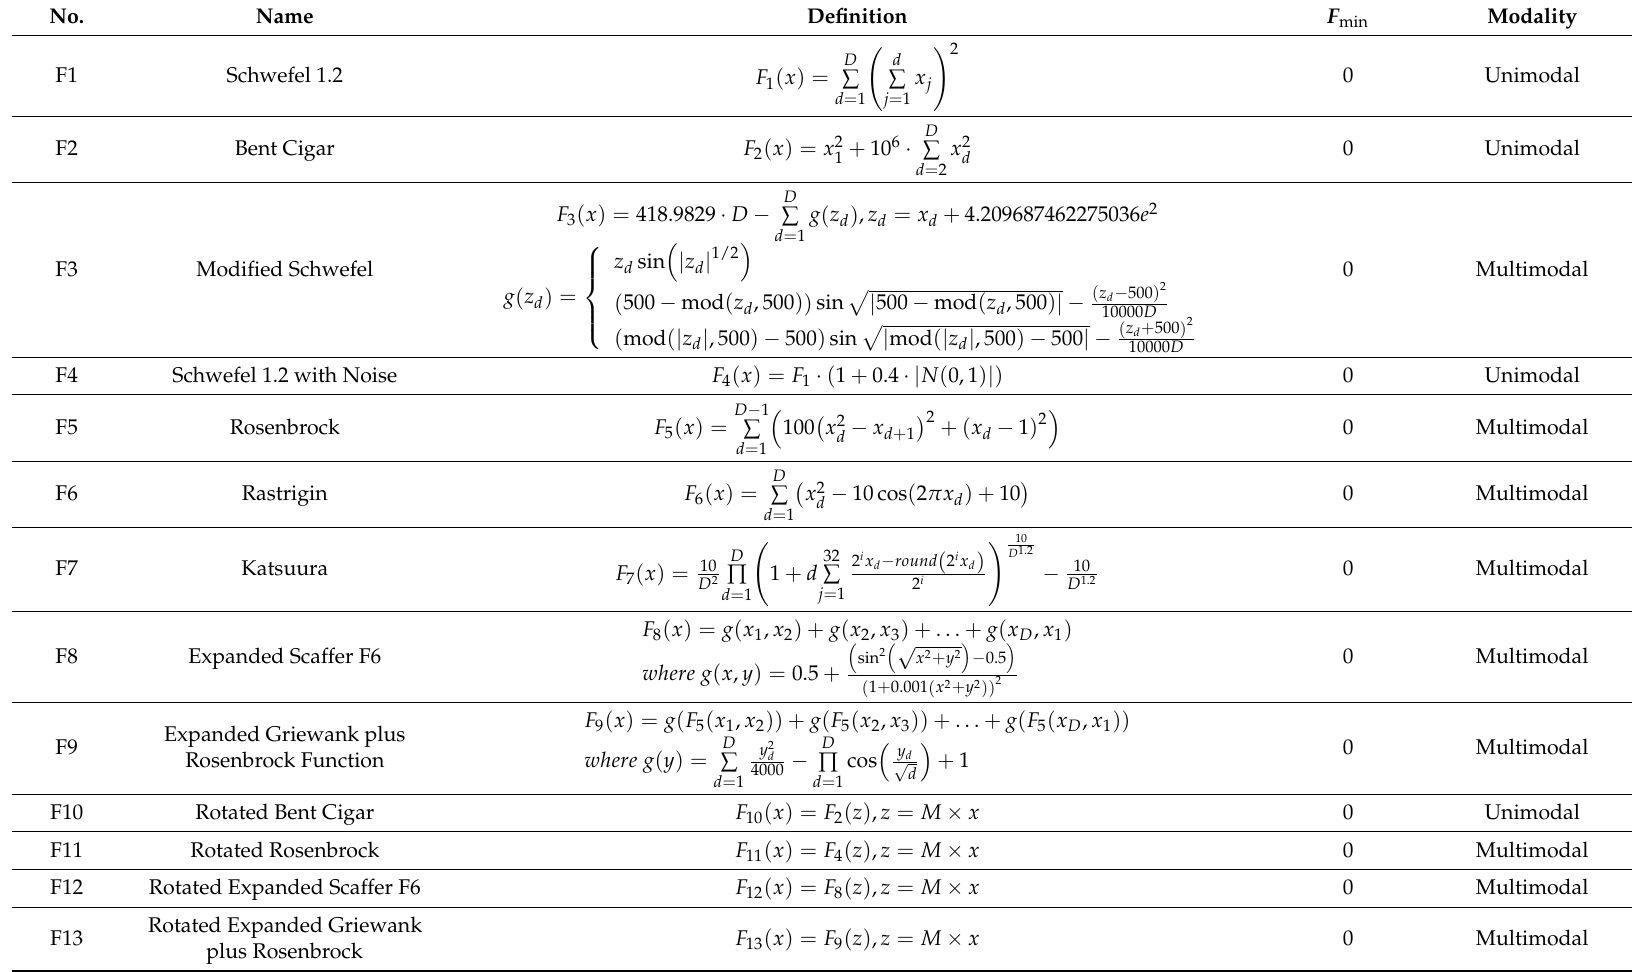
Table 1. Description of the benchmark